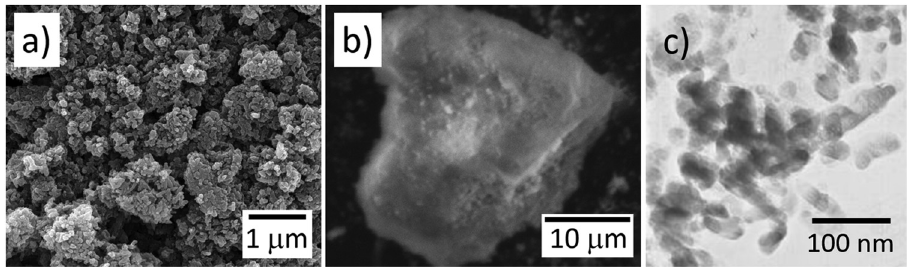
Figure 5: Representative images of the HA powder, SEM images ( a ) before and ( b ) after calcination at 700 o C for 2 h, and ( c ) TEM image of the uncalcined powder.